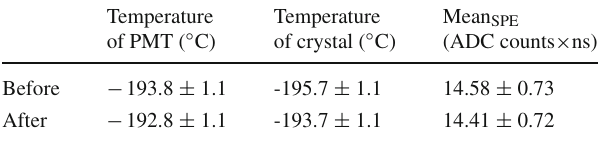
Table 1 Summary of single-PE response measurements before and after the energy calibration to be mentioned in the next section